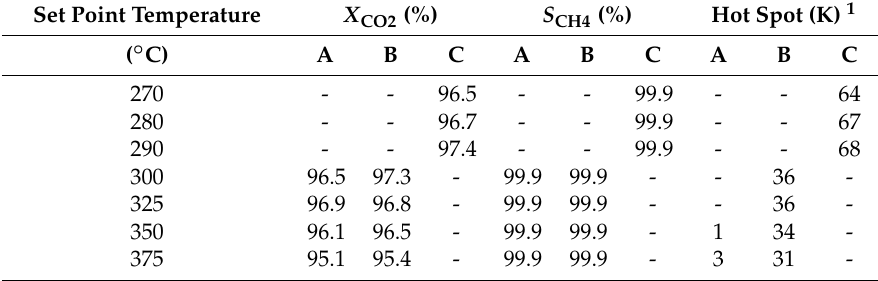
Table 2. Carbon dioxide conversion and methane selectivity during runs with decreasing